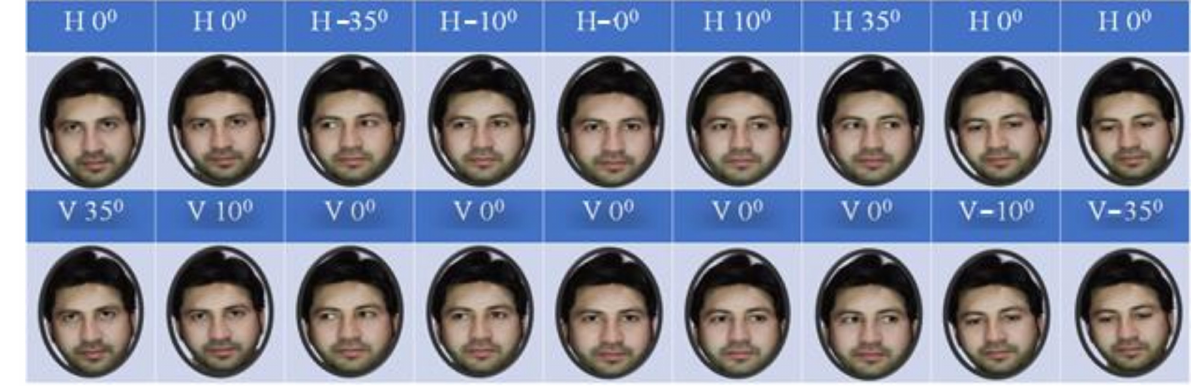
Figure 3. Selected eye gaze directional points of the custom-developed dataset.